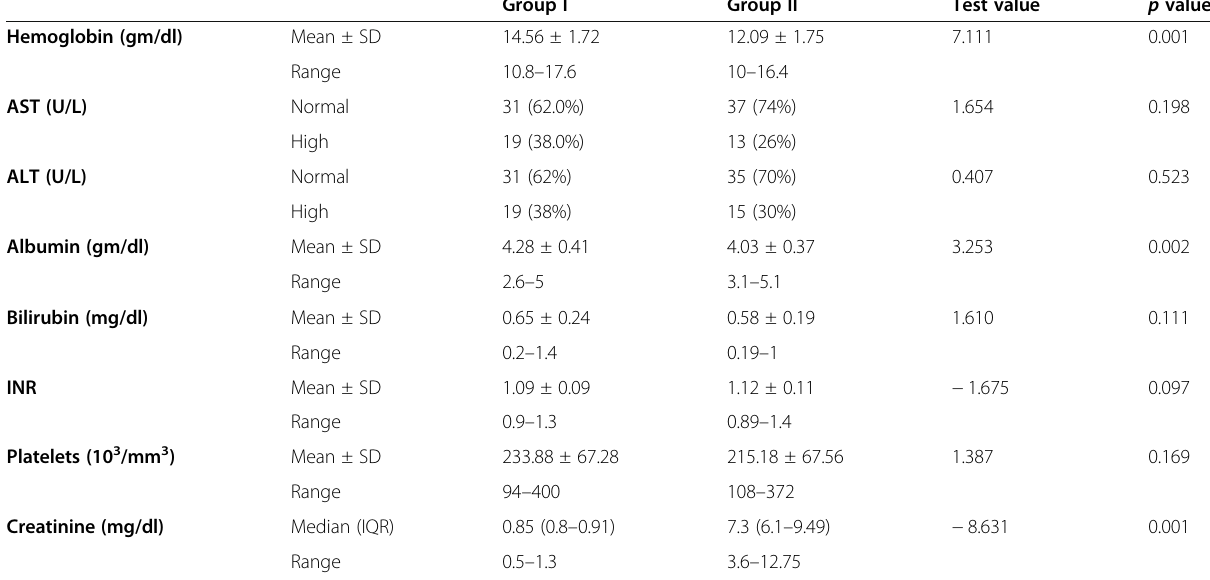
Table 3 Comparison between group I (control group) and group II (case group) regarding levels of hemoglobin, AST, ALT, albumin, total bilirubin, INR, platelets, and creatinine before start of treatment